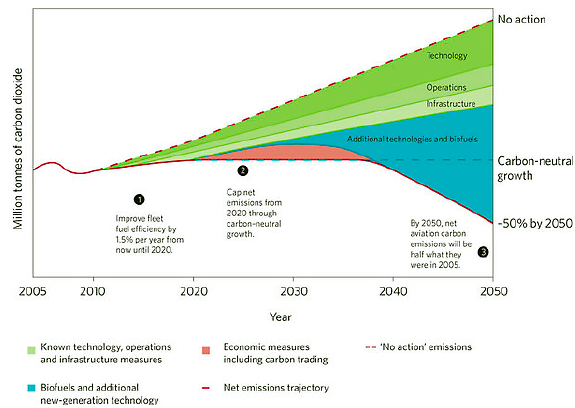
Fig. 1. Pollutant emission trends for the period